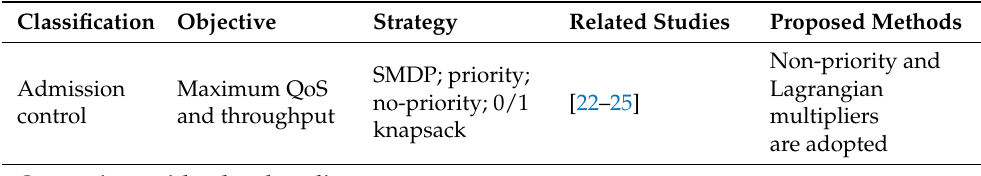
Comparison with related